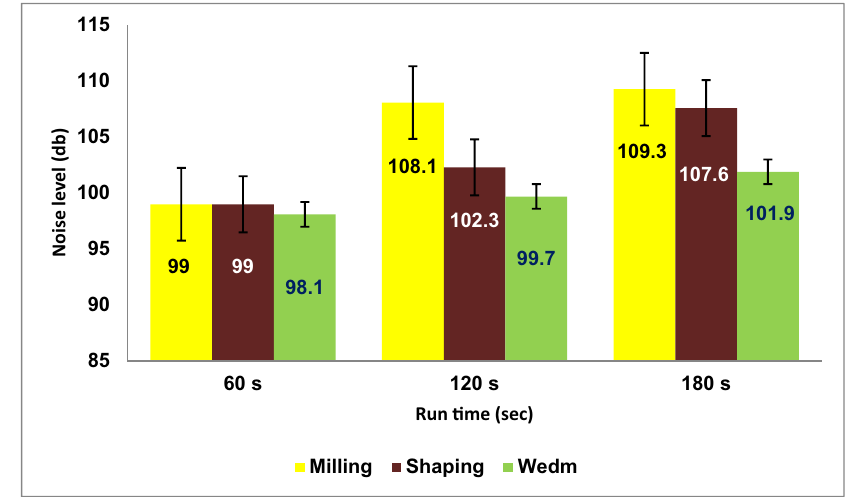
Figure 10: Comparative graph of noise level for milling, shaping, and WEDM processed